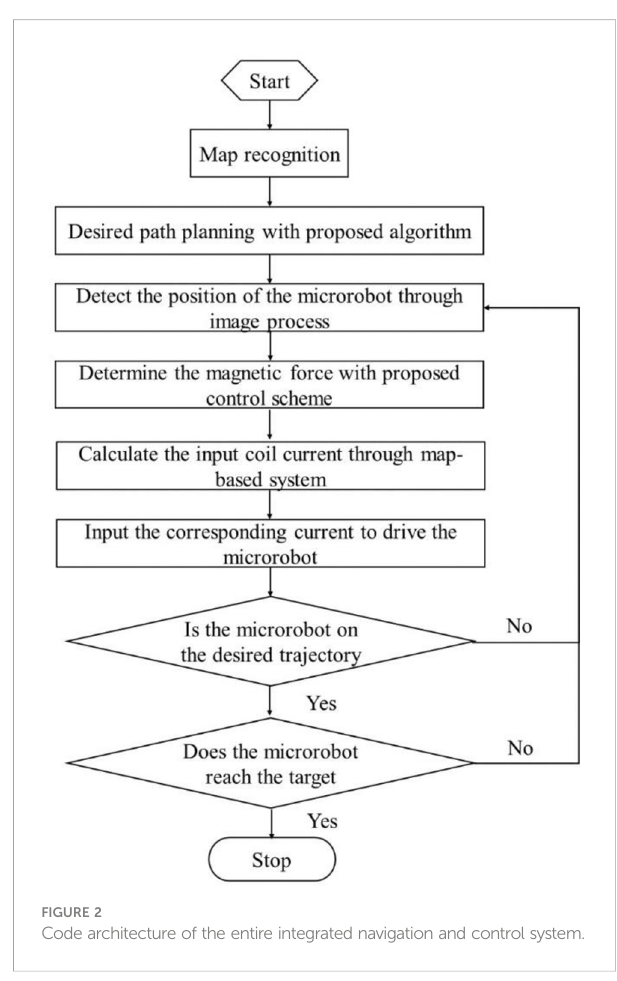
FIGURE 2 Code architecture of the entire integrated navigation and control